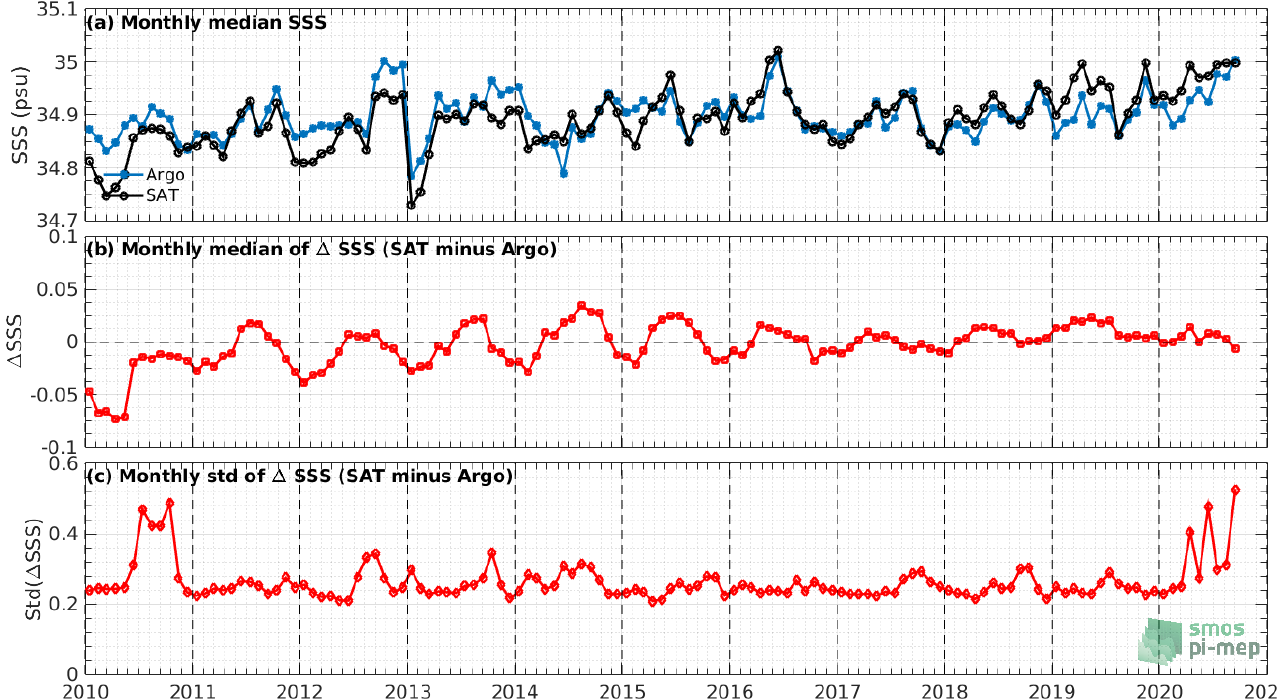
Figure 9. Time series of the monthly median SSS, median of ∆ SSS (Satellite−Argo) and STD of ∆ SSS (Satellite−Argo) over the Global Pi-MEP region considering all match-ups collected by the